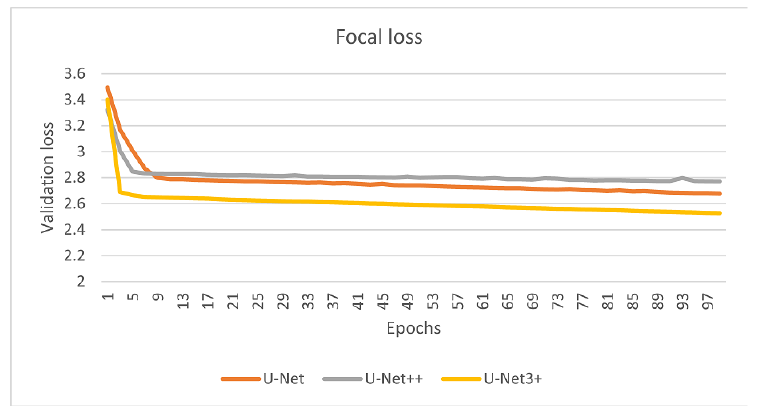
Figure 21. The progress of focal loss during training for the validation